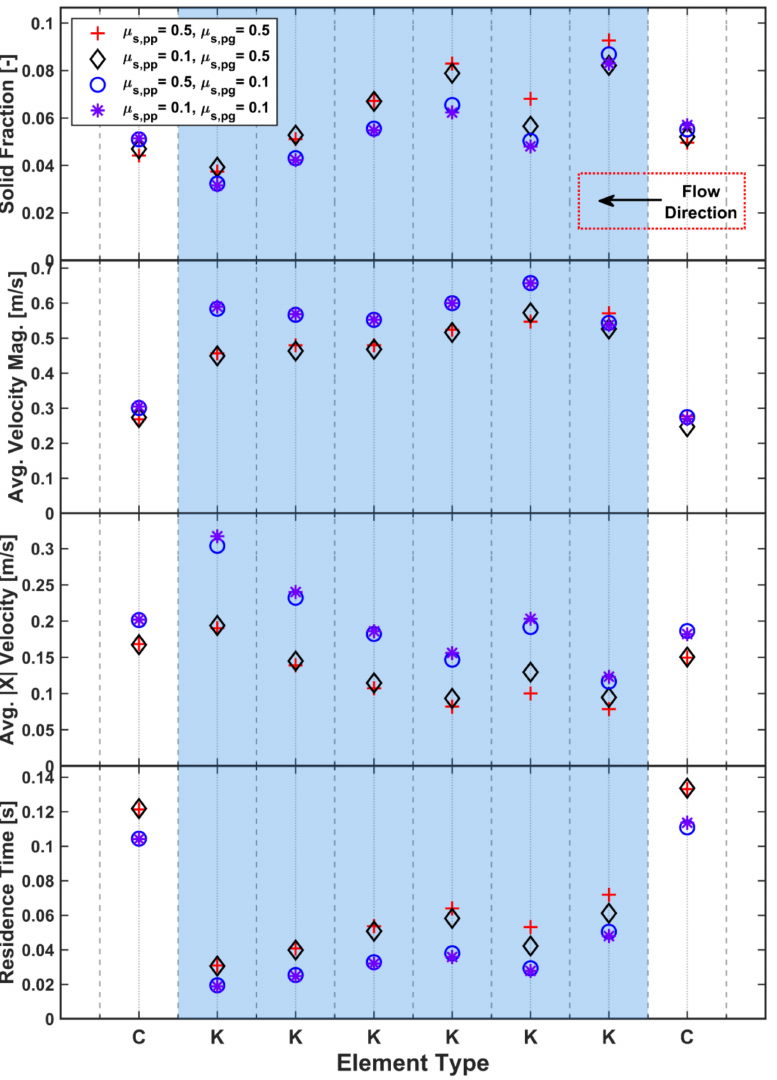
Figure 14. Effect of static friction coefficient on solid fraction, velocity and residence